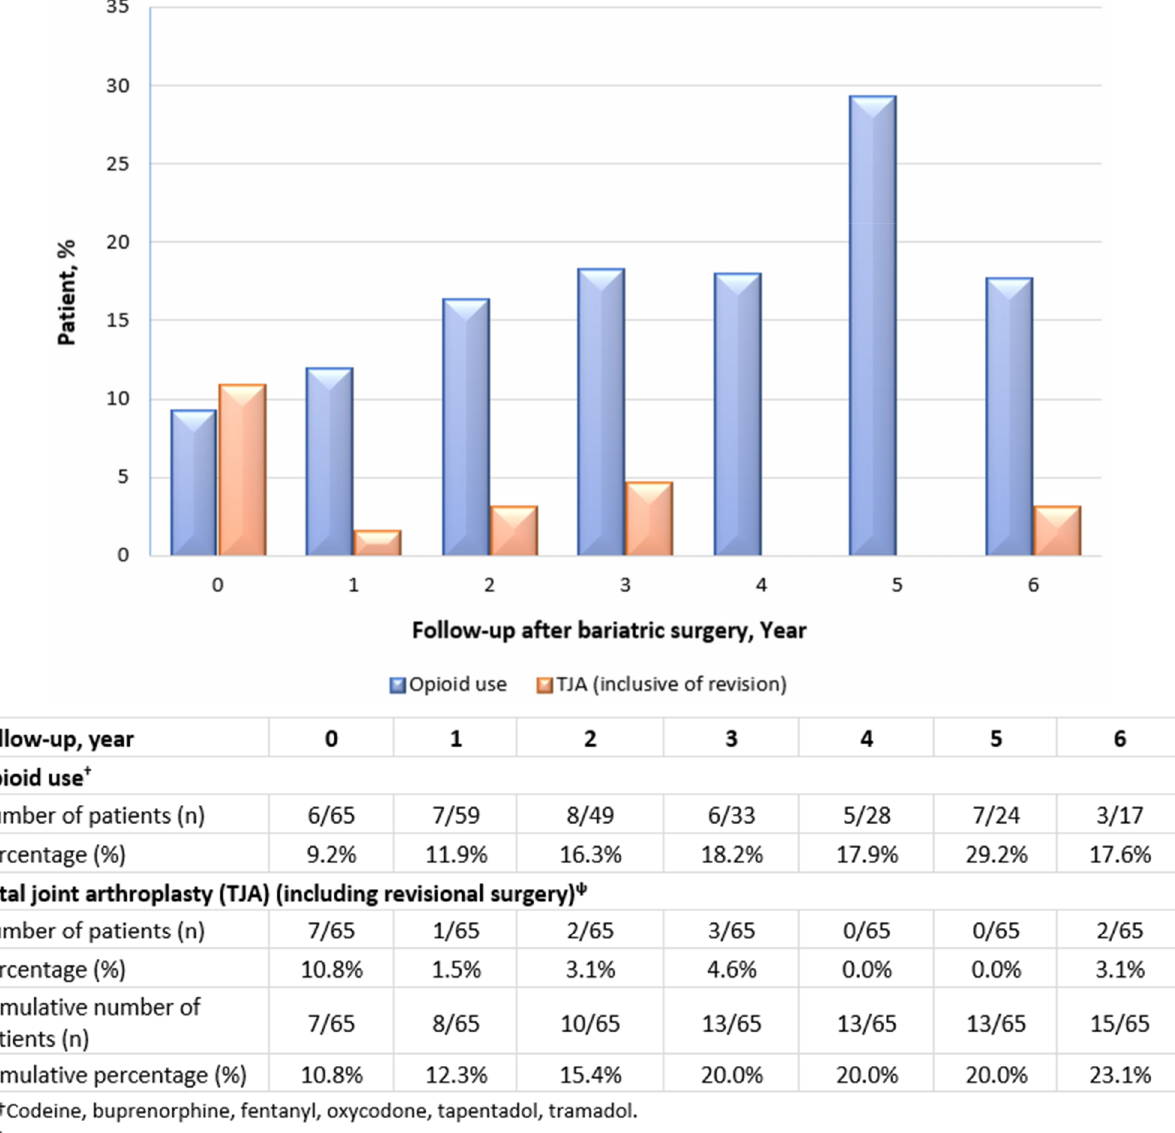
Figure 5. Prevalence of prescribed opioids and incidence of TJA among patients with OA-related joint pain.